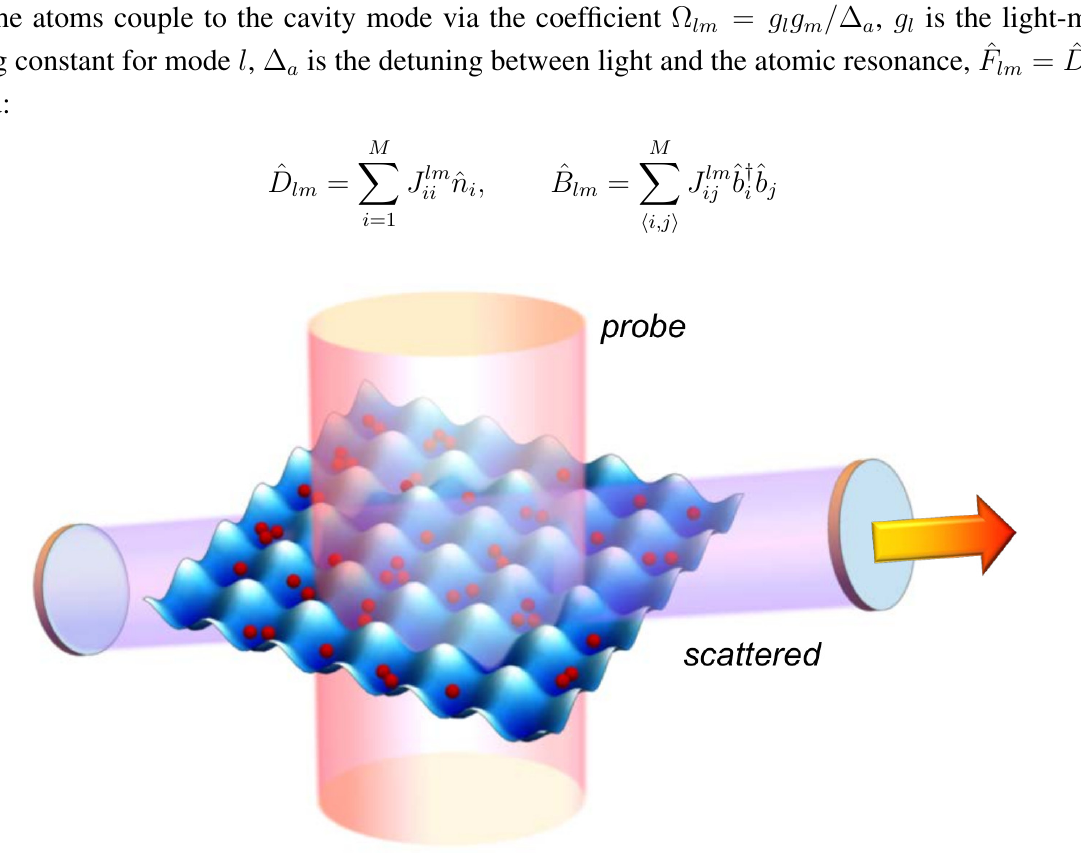
Figure 1. Setup. Atoms in an optical lattice are illuminated by a probe beam (red), and the scattered light (blue) is selected and enhanced by an optical